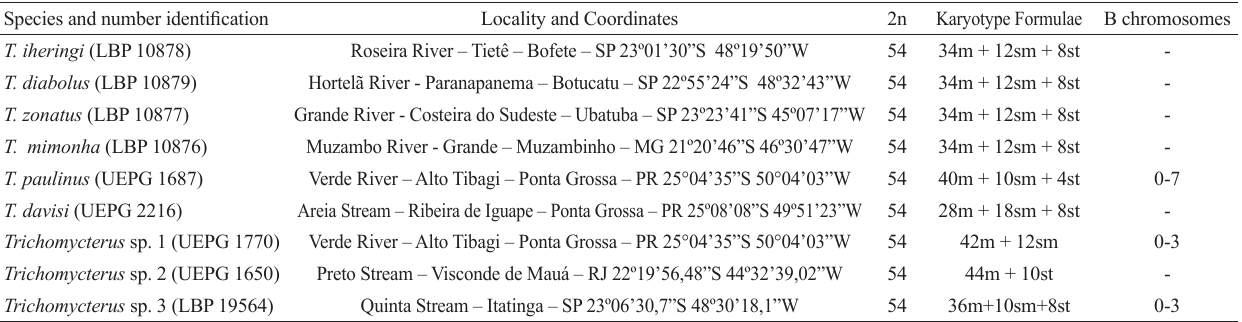
Table 1. Species of Trichomycterus analyzed in the study indicating the collection sites, diploid number, occurrence of B chromosomes and karyotypic